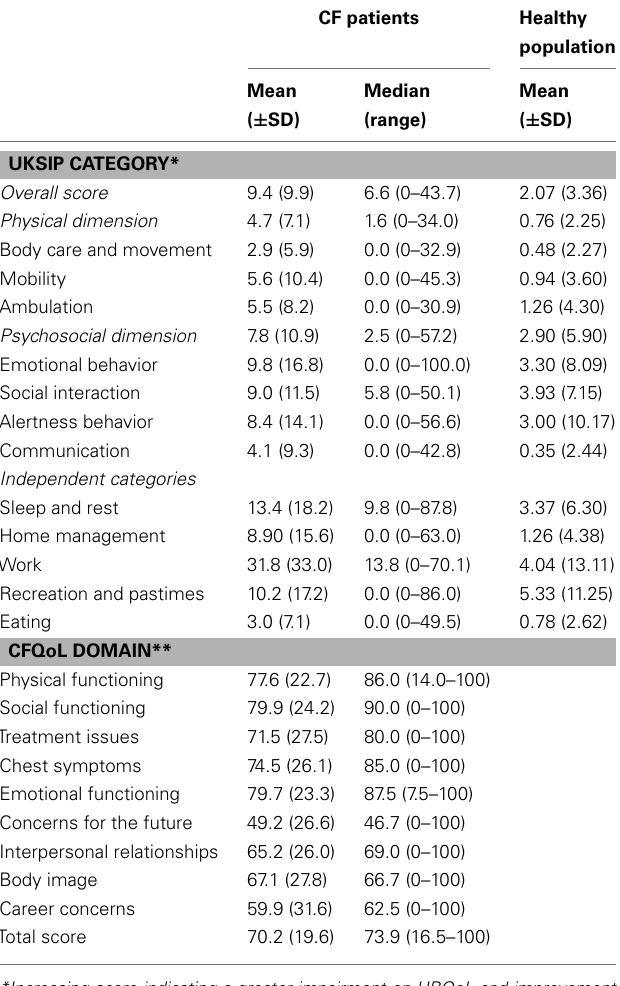
Table 4 | Mean and median HRQoL scores as measured by the UKSIP ( n = 70) and the CFQoL ( n =